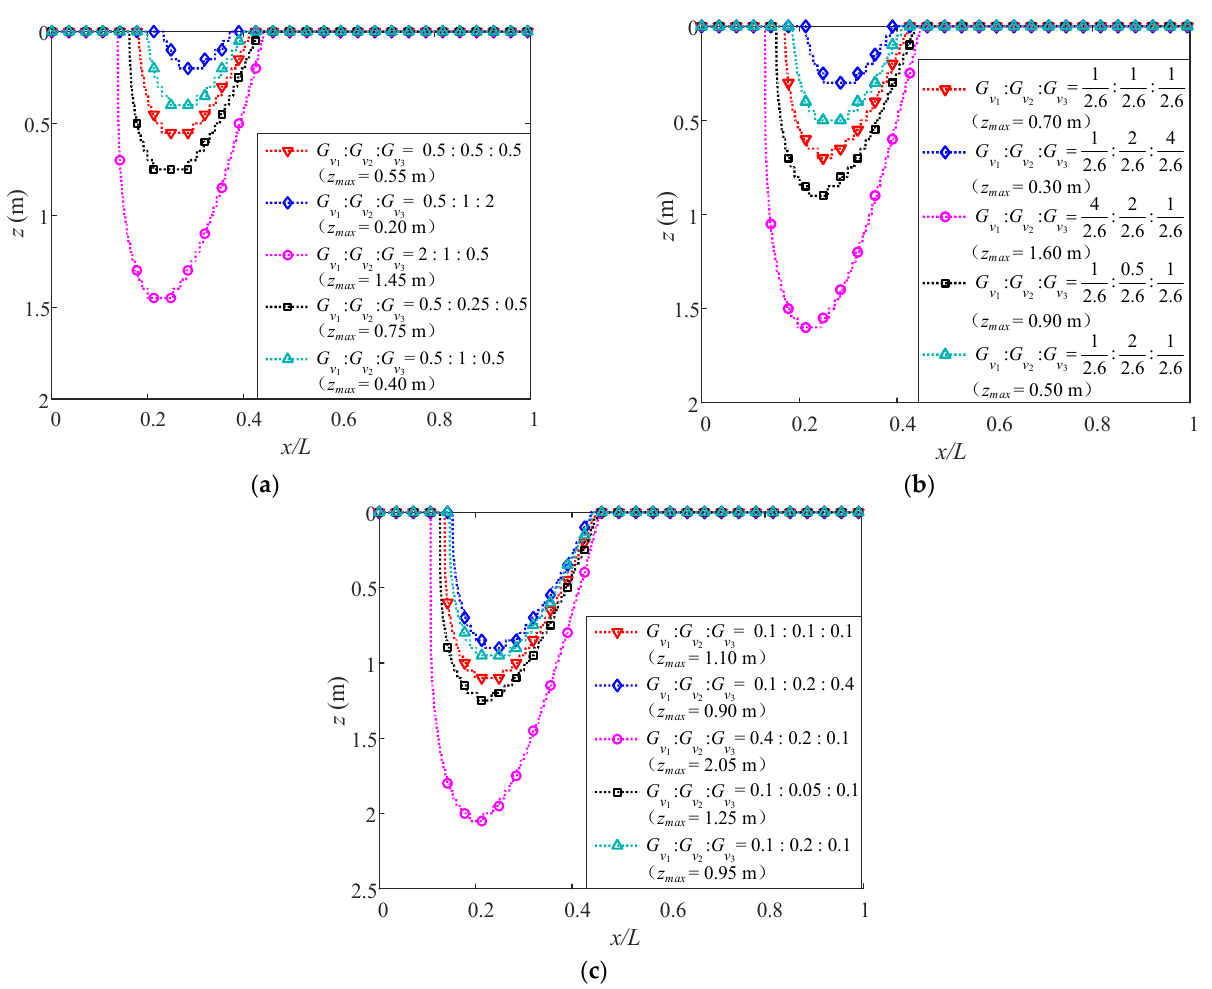
Figure 20. Liquefaction depth along wave propagation at t = 20 s with ( a ) G vo / E vo = 0.5, ( b ) G vo / E vo = 1/2.6 (isotropic), and ( c ) G vo / E vo = 0.1 ( o = 1, 2, 3).